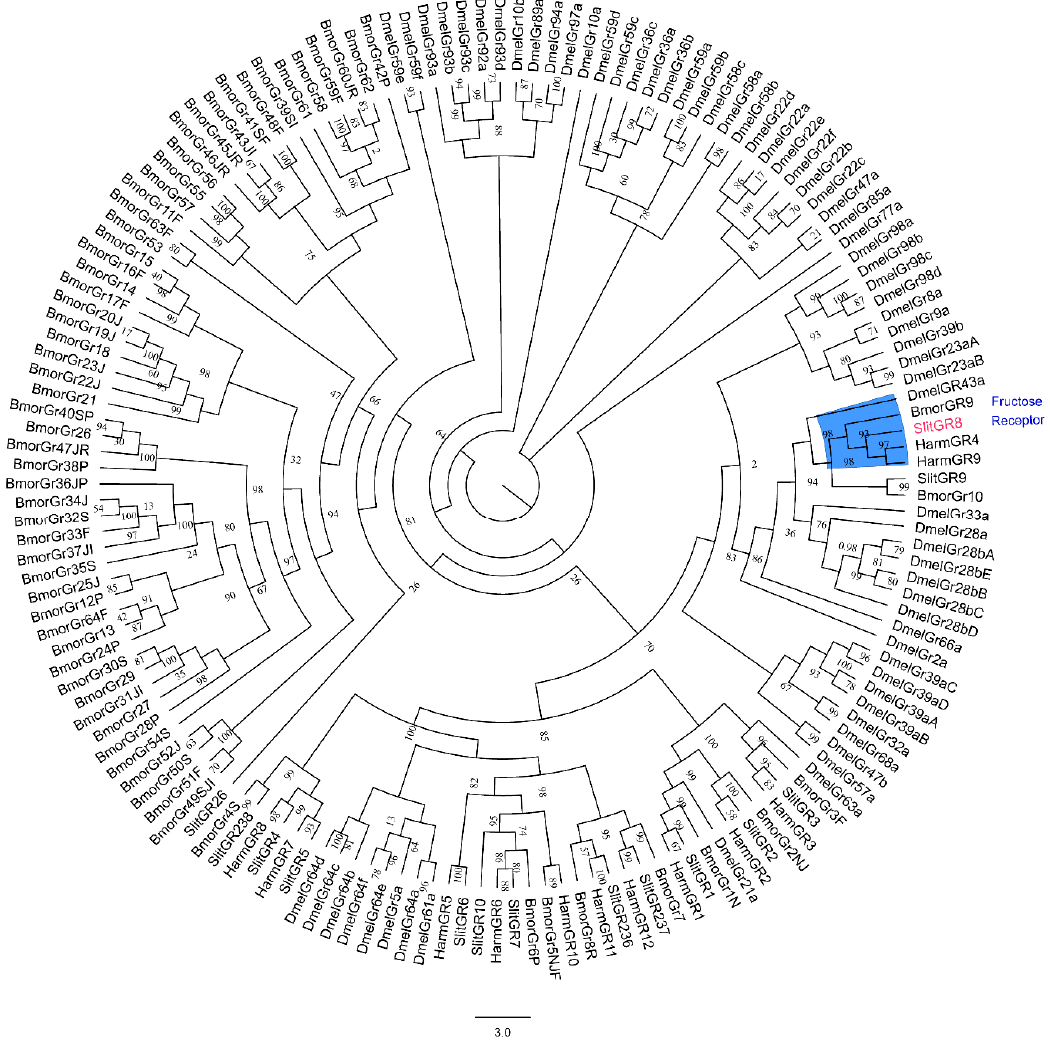
Figure 2. Phylogenetic tree of the amino acid sequences of SlitGR8 and other GRs, including all functionally characterized fructose GRs from other species of D. melanogaster , B. mori , and H. armigera . The tree was constructed by neighbor joining method with a bootstrap of 1000. Fructose receptor clad is marked in blue color. SlitGR8 is in red color.